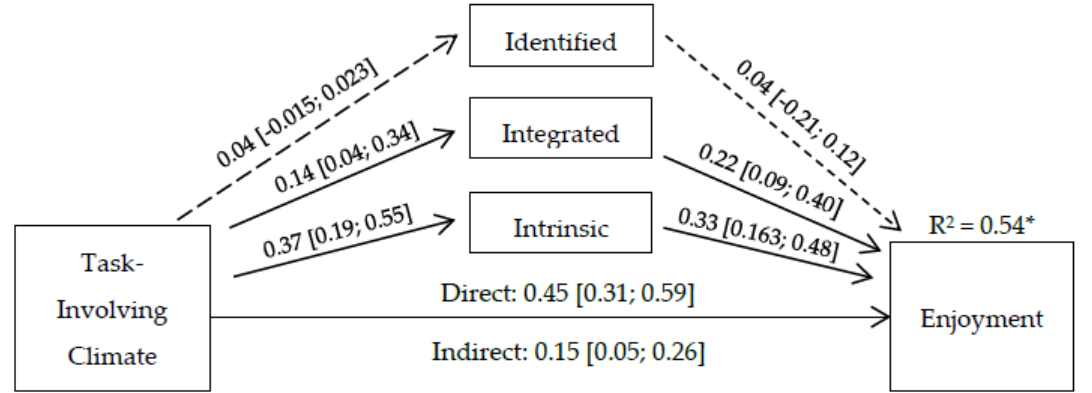
Figure 1. Multiple mediation analysis. Note: * p < 0.001, between squared brackets = confidence interval at 95%, full arrow = significant effect, dashed arrow = non-significant effect.